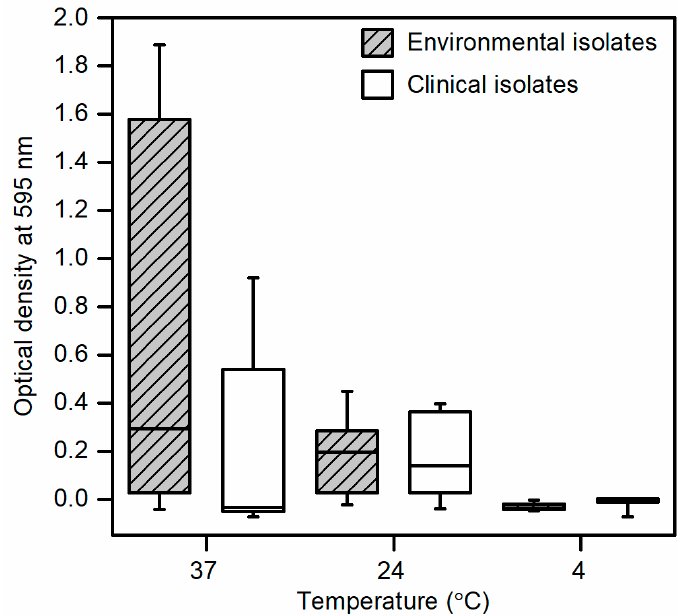
Figure 3. Biofilm formation of environmental and clinical Escherichia coli isolates in 100% LB broth and 8 log CFU/mL inoculum size incubated at temperatures of 37 °C, 24 °C, and 4 °C for optimiza- tion of the two-component apparatus. Data presented as means ± standard deviations of triplicate experiments.